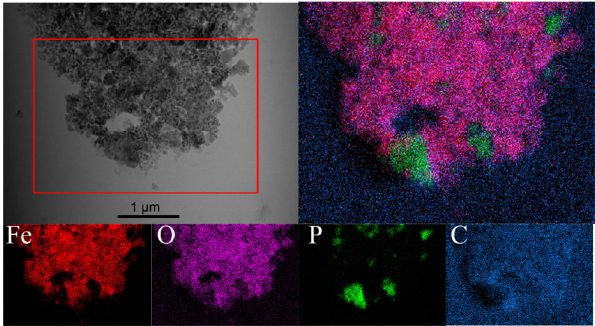
Fig. 26 The distribution of the chemical elements in wear debris.